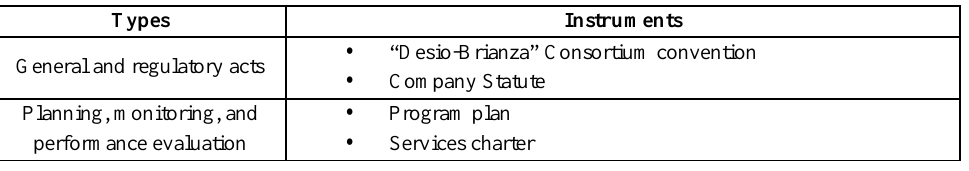
Table 2: Business Management